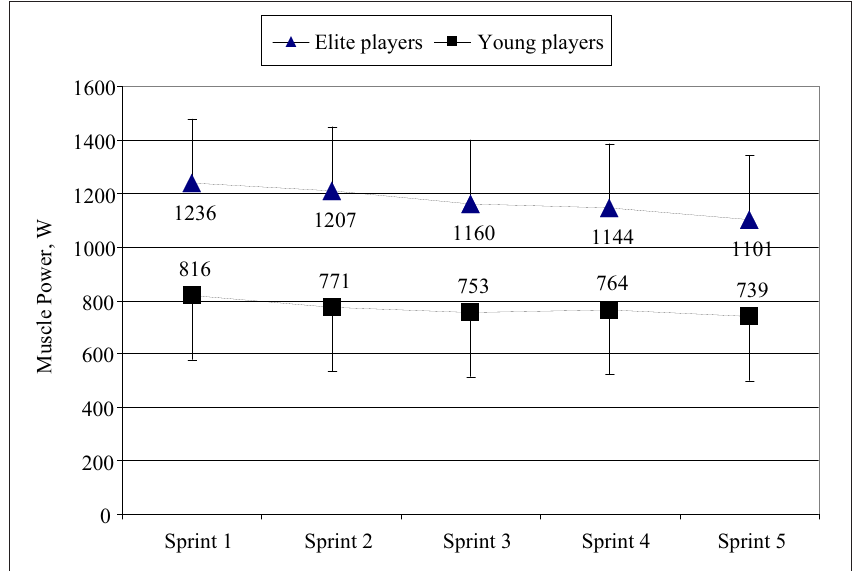
Figure 1. Change in absolute muscle power (W) of elite